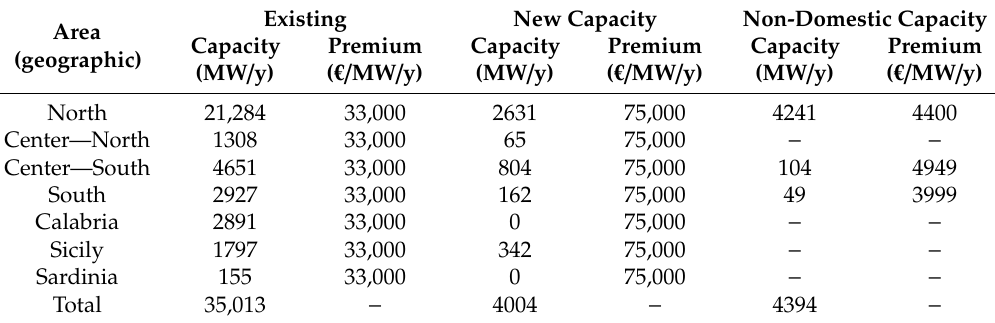
Table 6. Granted capacity under the 2023 capacity auction